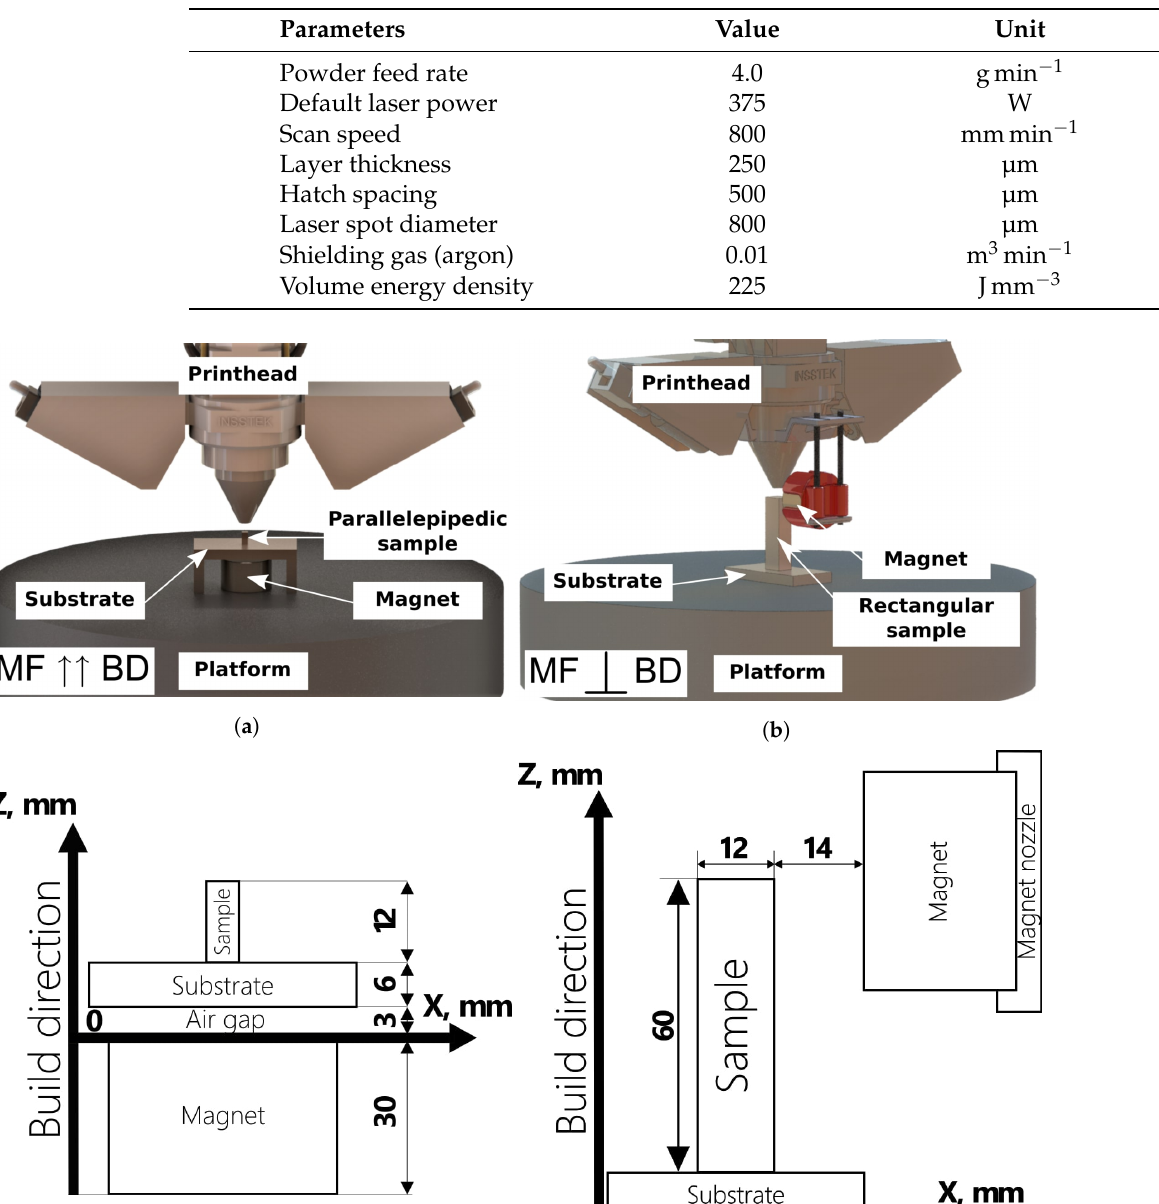
Table 1. The printing parameters recommended by InssTeK.